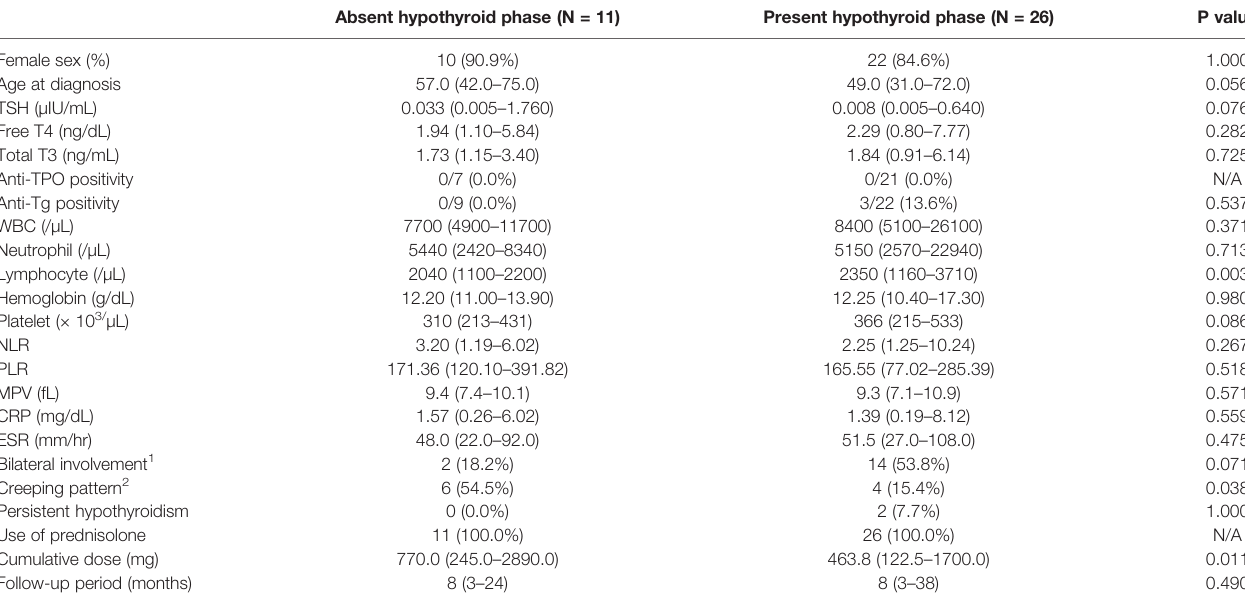
TABLE 2 | Subgroup analysis based on the development of hypothyroid phase.